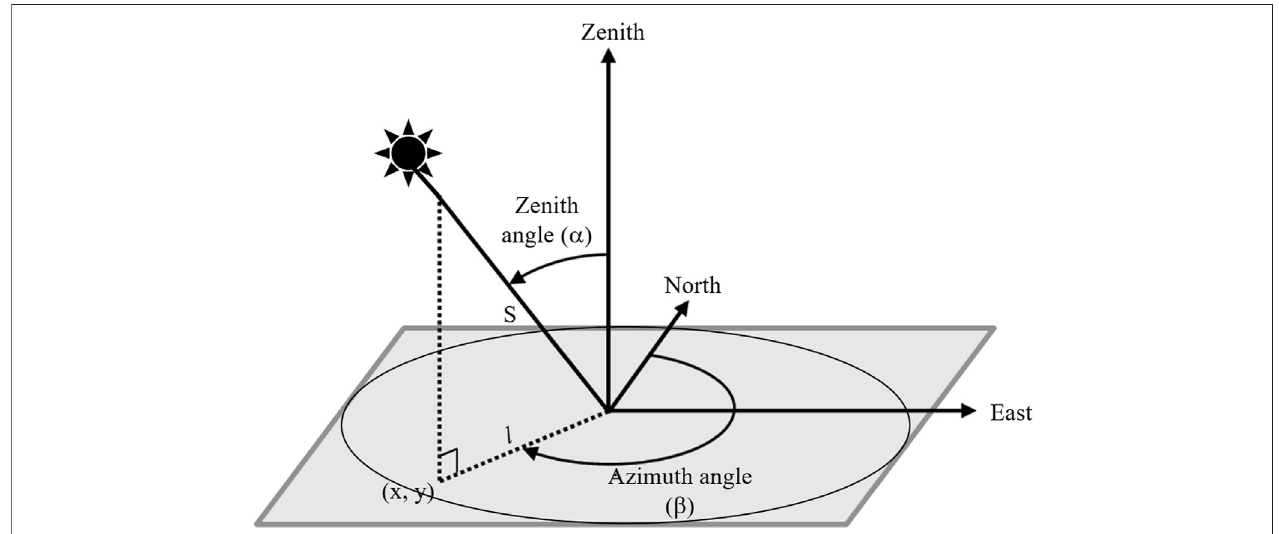
FIGURE 5 | Zenith angle and Azimuth